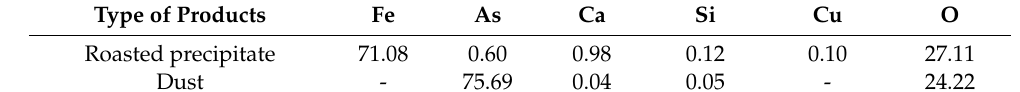
Table 3. Chemical composition analysis of arsenic–iron precipitate /wt.%.